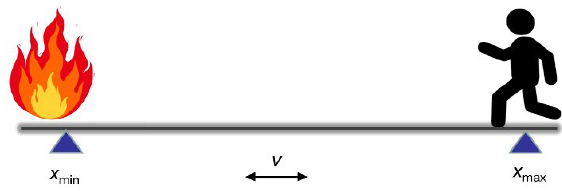
Figure 2. Schematic diagram of the firefighting scene.